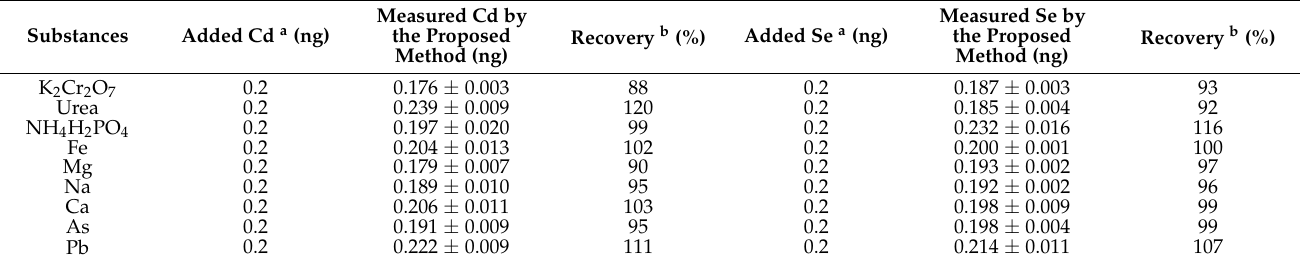
Table 1. The interference of potential substances ( n = 3).